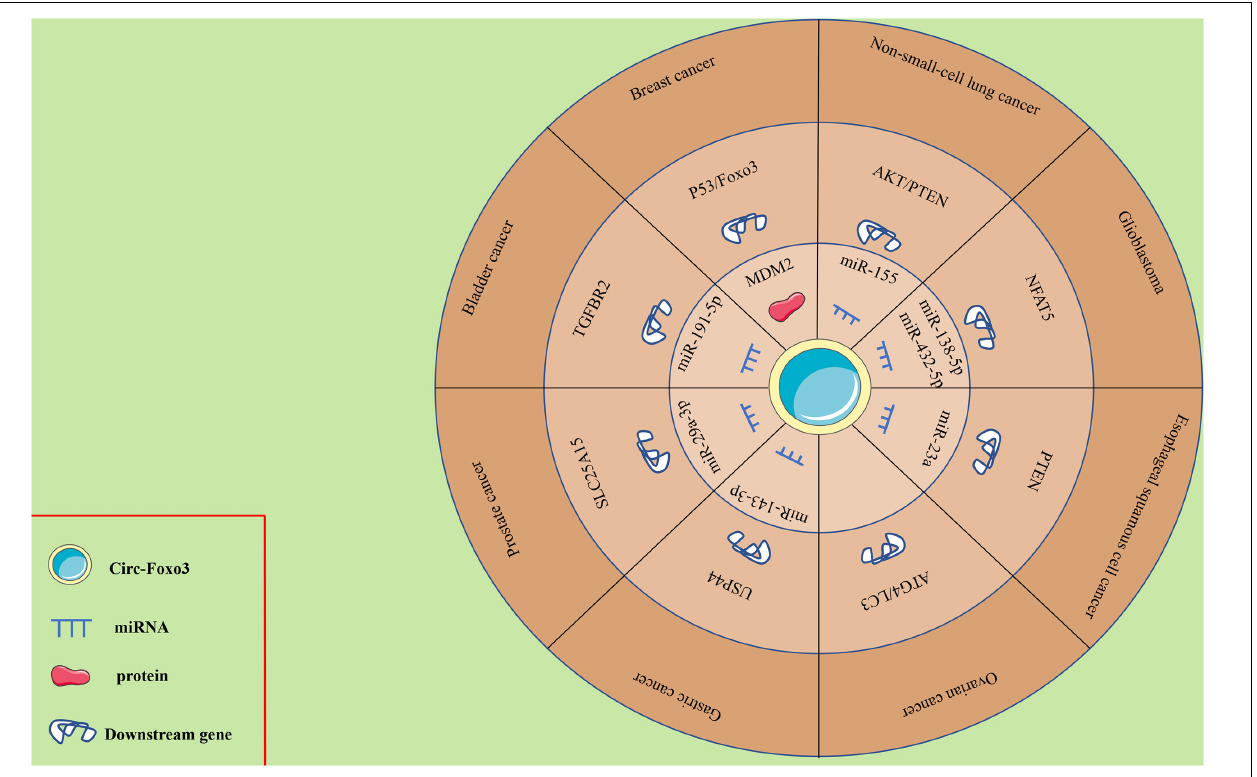
FIGURE 2 | Circ-Foxo3 mediates mechanisms involved in diseases